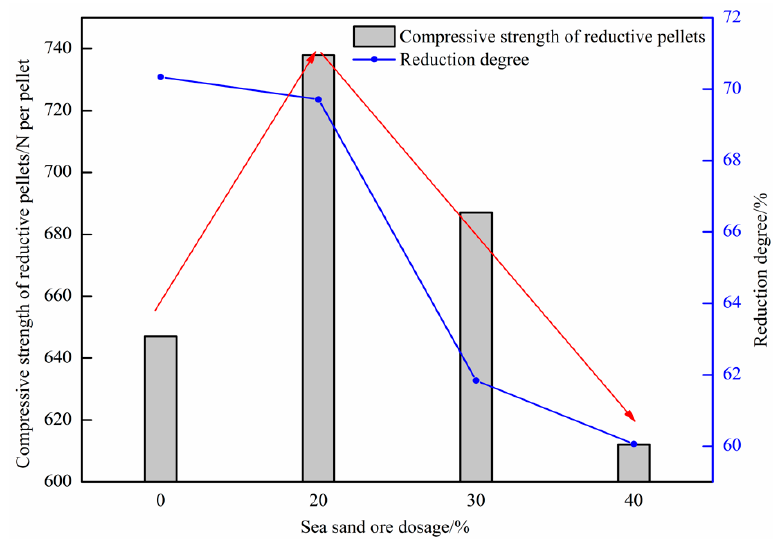
Figure 14. Effect of the sea sand ore dosage on the reduction degree of the oxidized pellets and the compressive strength of the reductive pellets.